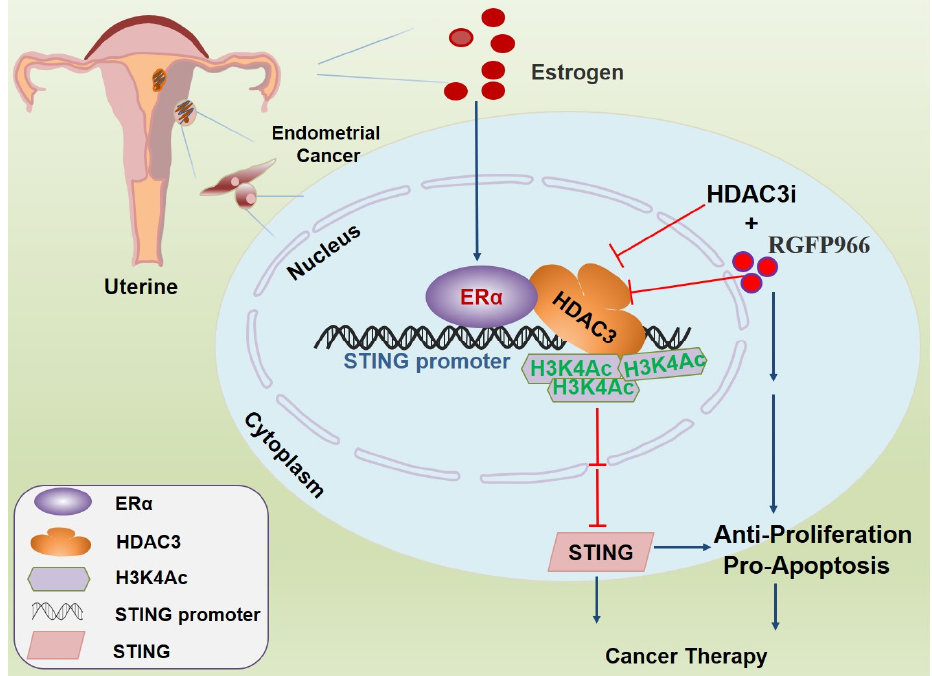
Figure 7. Mechanism of HDAC3-dependent expression of STING in β -estradiol-ER α -mediated en- dometrial tumorigenesis. In endometrial cancer, the stimulation of interferon genes STING